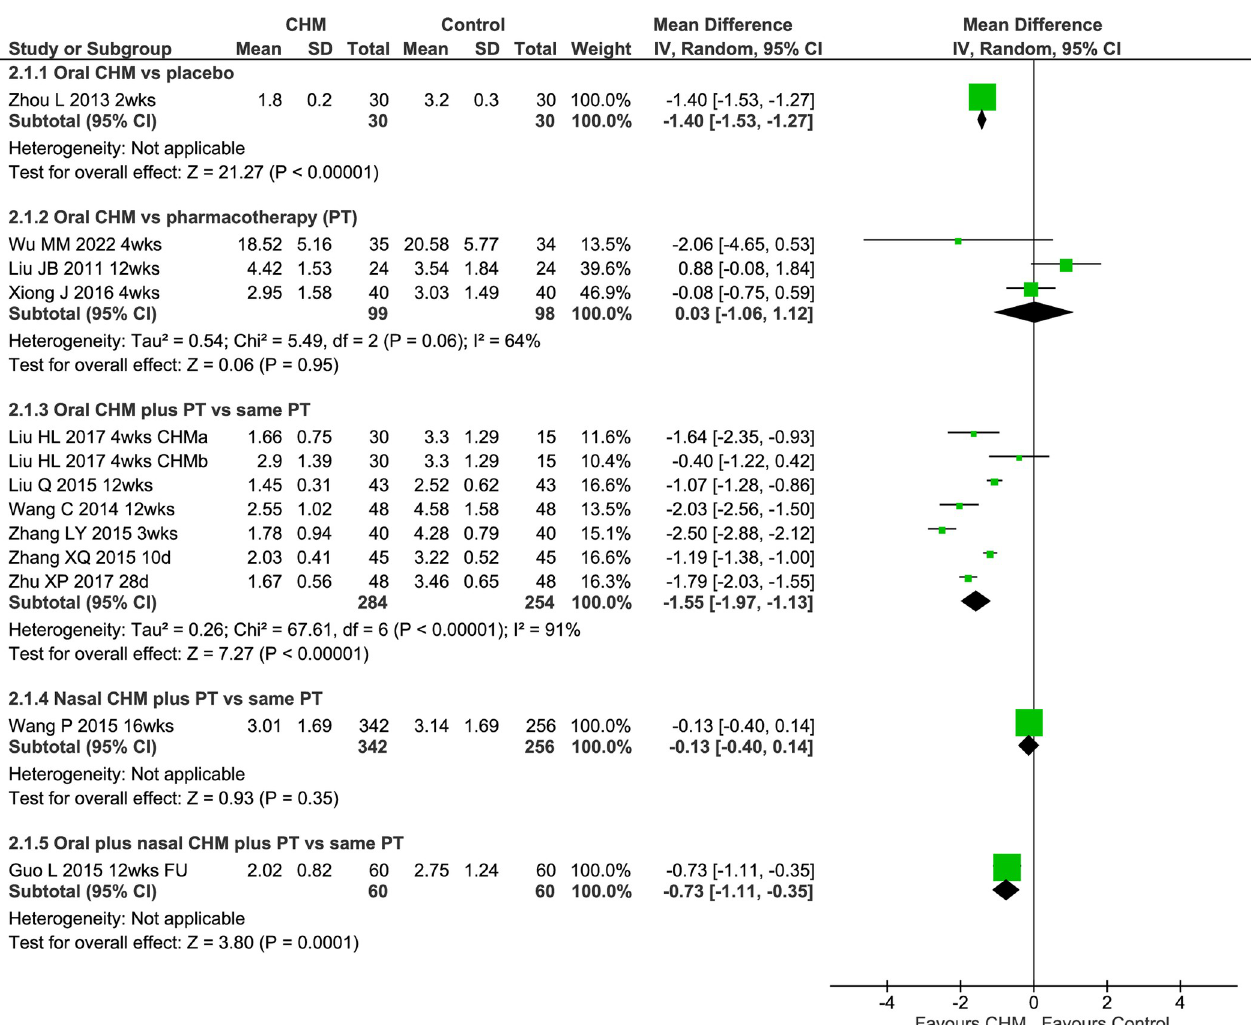
Fig 3. Forest plot of CHM for CRS at end of treatment for VAS-TNS. Abbreviations: CHM: Chinese herbal medicine; CRS: chronic rhinosinusitis; FU: follow-up; VAS: Visual analogue scale; TNS: total nasal symptoms; PT: pharmacotherapy; vs: versus; wks: weeks.